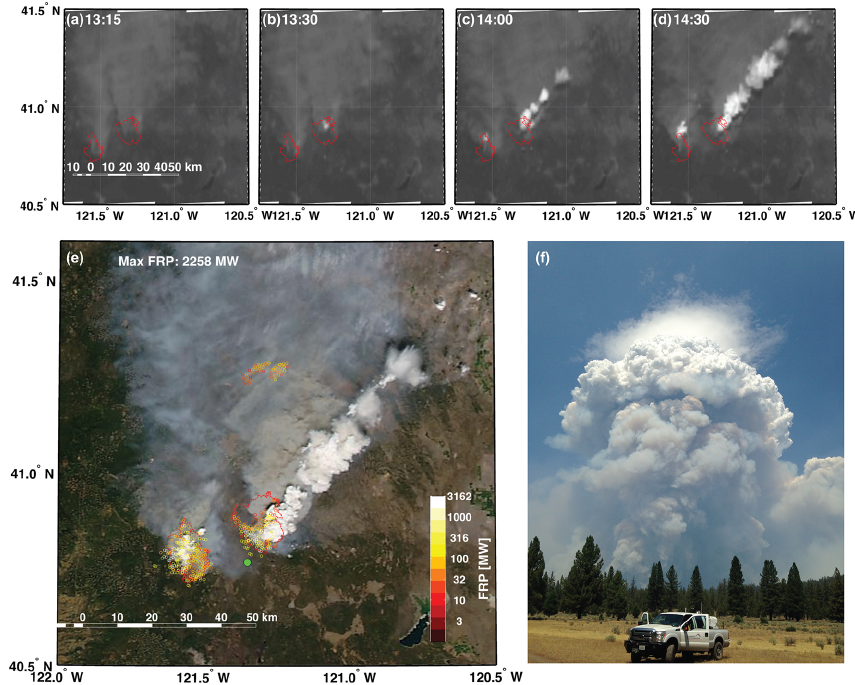
Figure 4. Overview of the pyrocumulus initiation and growth on 2 August 2014. (a–d) GOES-15 visible imagery showing the pyroCu initiation. (e) MODIS-Aqua visible image at 14:26PDT along with fire-radiative power (FRP, colored circles). (f) Photograph of the lidar vantage point and the windward edge of convective column and pyroCu at 14:01PDT. The truck location is indicated in as a green dot in (e) . The fire perimeters are as in Fig. 3.